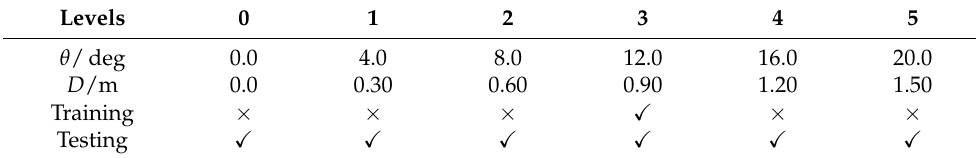
Table 1. Different calibration situations for verification on deep learning based methods.